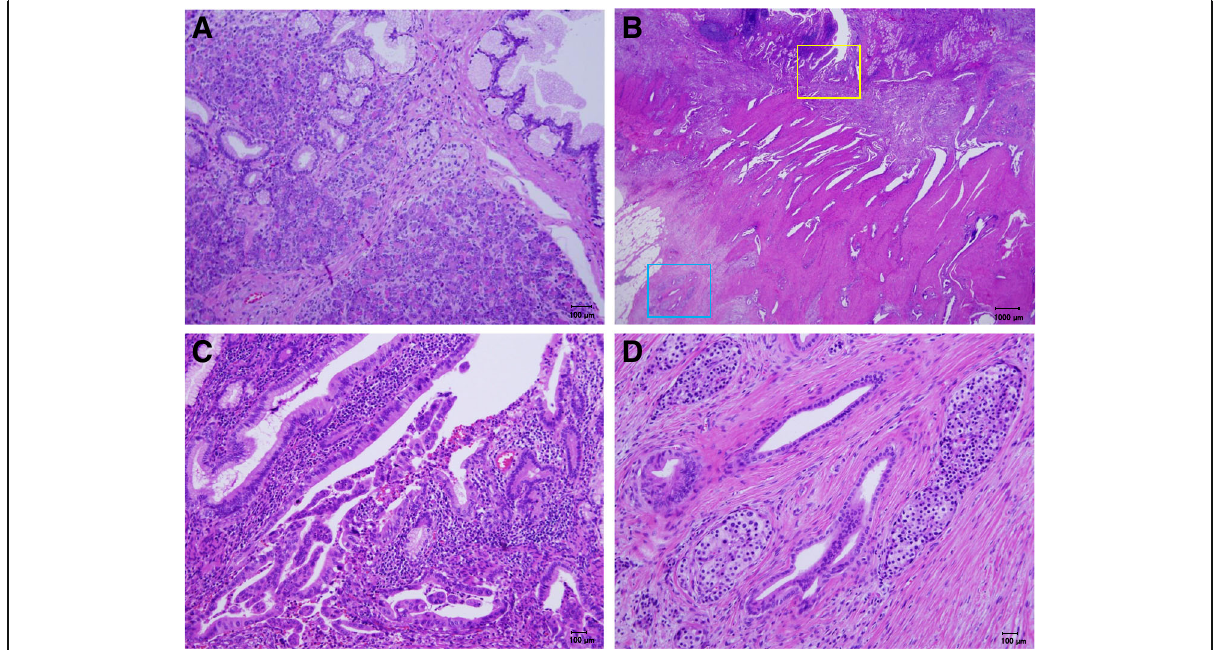
Fig. 5 a Ectopic pancreas of the duodenum showing pancreatic ducts, acinar cells, and islets called Heinlich type1. b Adenocarcinoma in the duodenum mainly located in extra-mucosal layer, and combined with ectopic pancreas, which is consistent with carcinoma derived from ectopic pancreas. Magnified figures in the square are shown in c (yellow) and d (blue). c Papillary adenocarcinoma of the duodenum derived from ectopic pancreas. d Ectopic pancreatic tissue composed of pancreatic ducts and islets in duodenal muscle